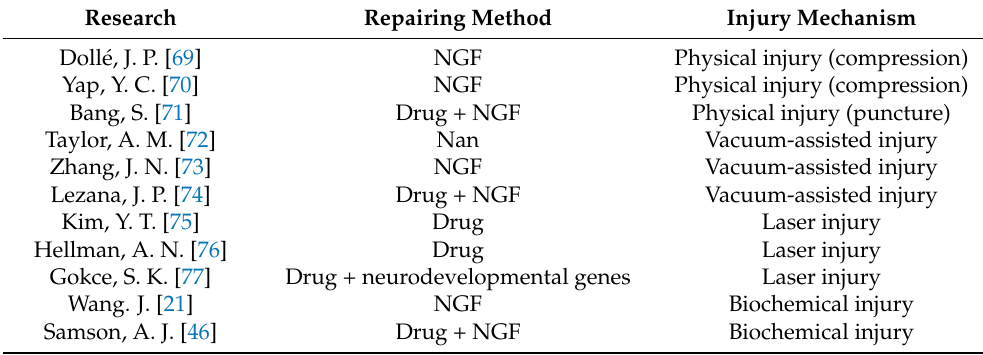
Table 3. Injury mechanisms and repair methods of different researches. Research Repairing Method Injury